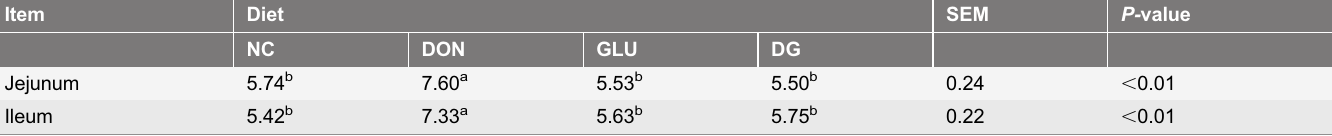
Table 3. Effects of glutamic acid on the Caspase-3 activity in the jejunum and ileum in piglets challenged with deoxynivalenol (%) 1 . Item